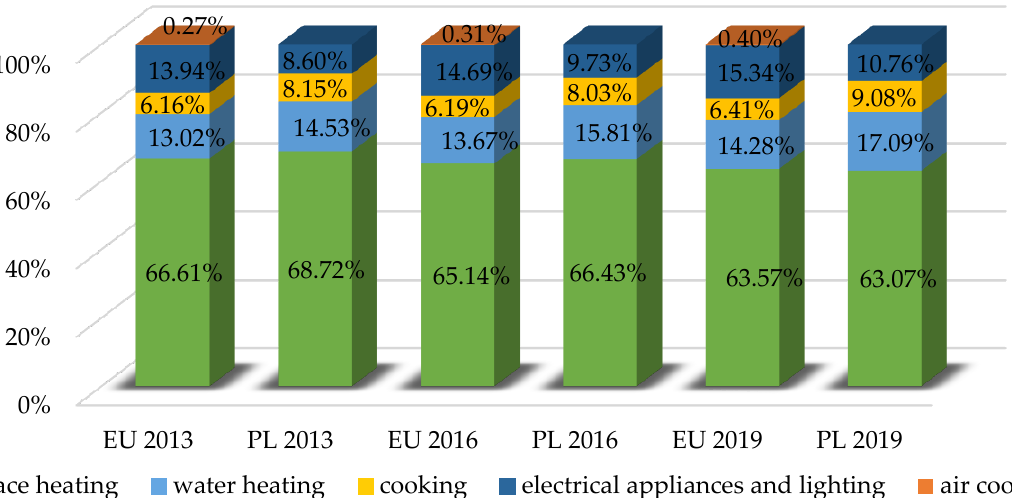
Figure 5. Structure of final energy consumption in households in 2013, 2016 and 2019. Own research based on Odysse [61].